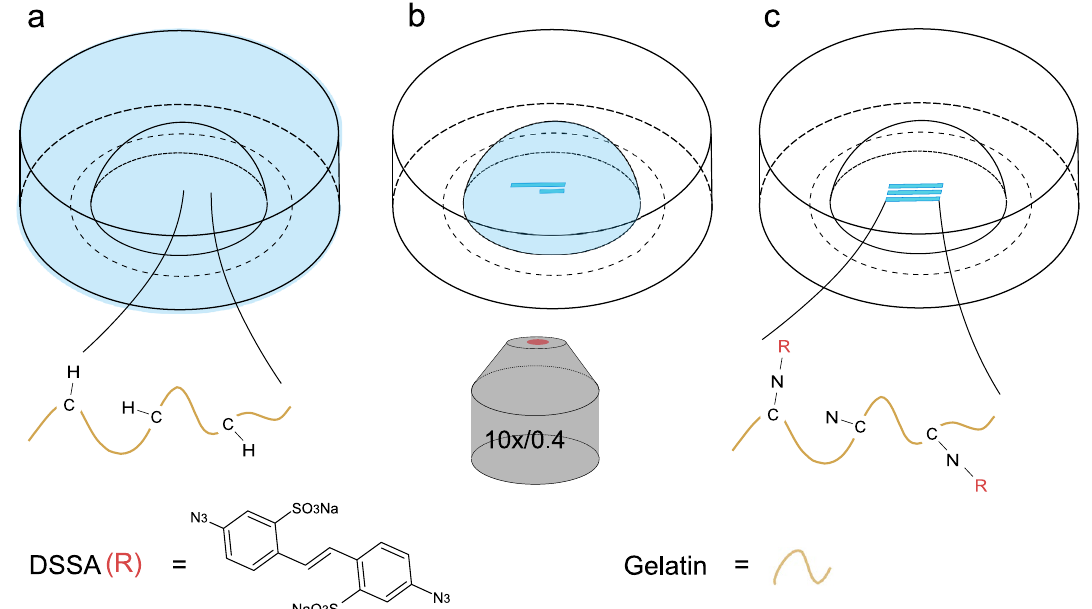
Figure 1. Schematic illustration of the DSSA multi-photon photografting process. ( a ) The UV-crosslinked gel-MA hydrogel pellet is soaked in a DSSA solution for 24 h. ( b ) Upon laser irradiation the azido group is group is photochemically decomposed into reactive nitrenes, ( c ) which covalently bind to C–H groups of